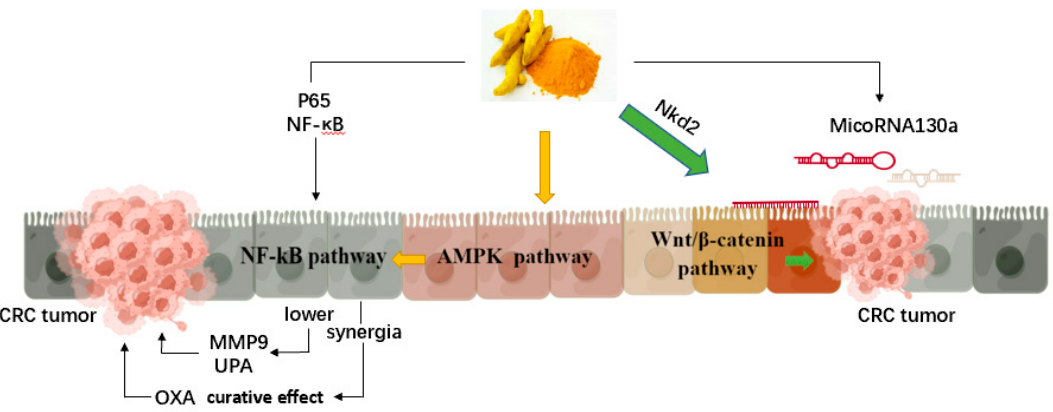
Figure 3. Mechanism of action of curcumin on colorectal cancer cells. Created by Figdraw.